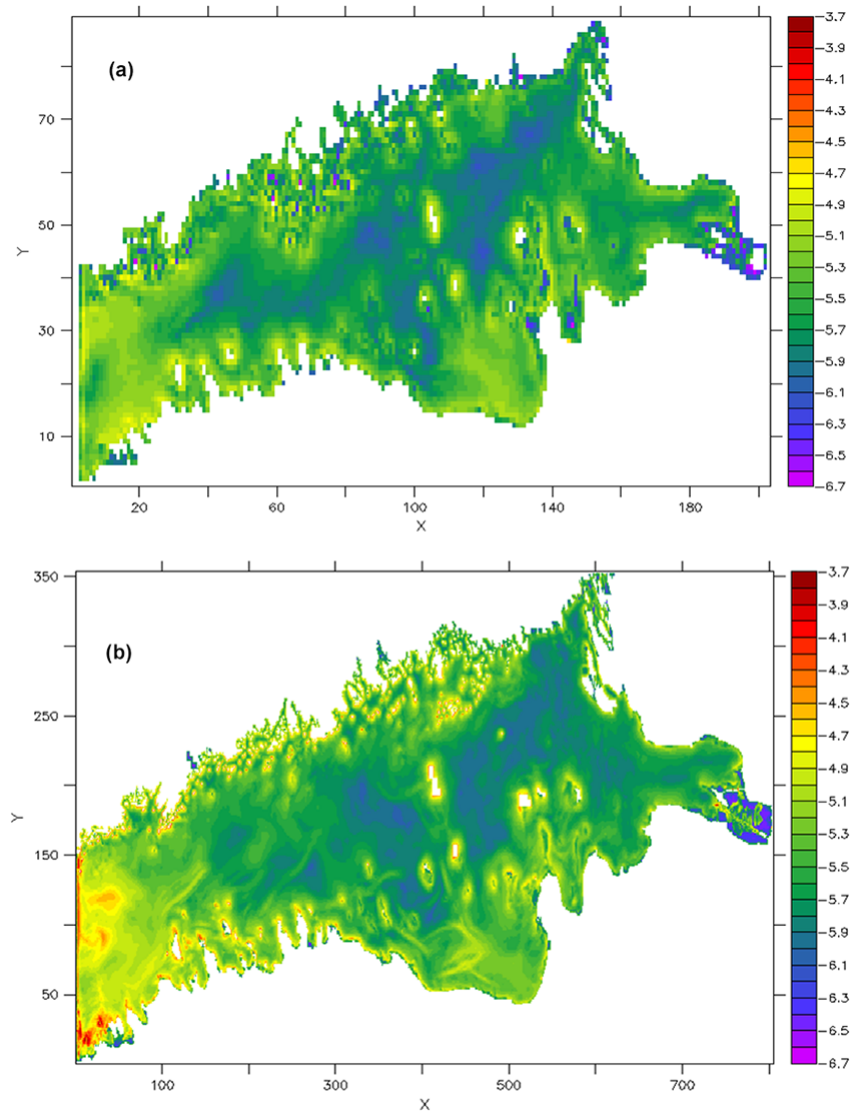
Figure 8. Vertical velocity absolute values (log scale) averaged for the depth of 5m and a 5-day interval: (a) 2km model grid, (b) 500km model